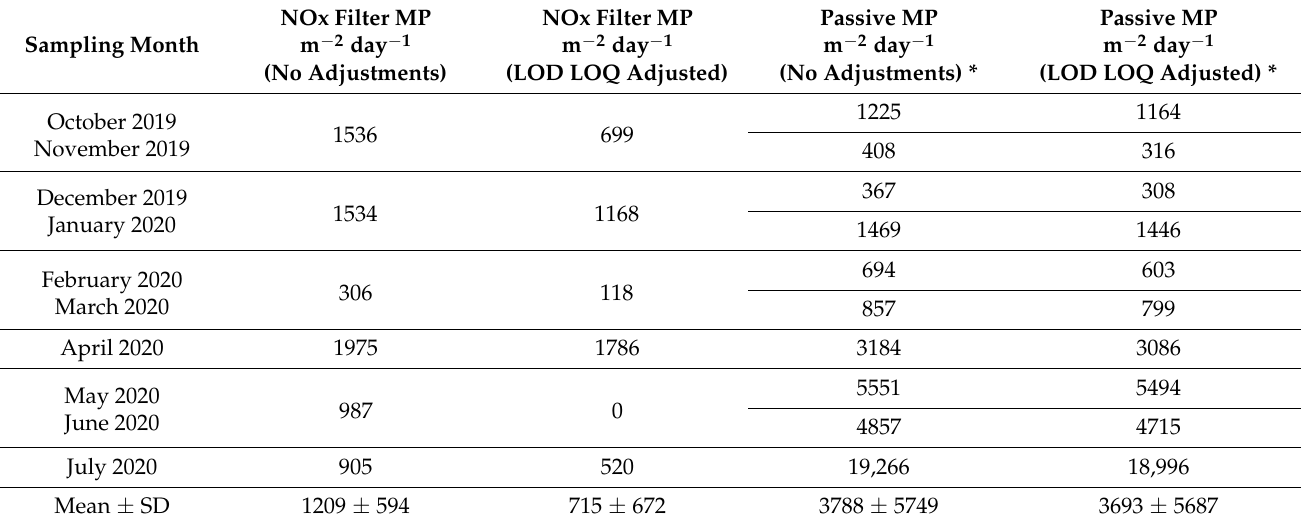
Table 1. MP levels detected at ‘A63’ roadside site, using the NOx inlet filters and * previously published passive rain sampler approaches [23], before and after LOD and LOQ adjustments. Octo- ber/November, December/January, February/March, May/June pooled data onto one